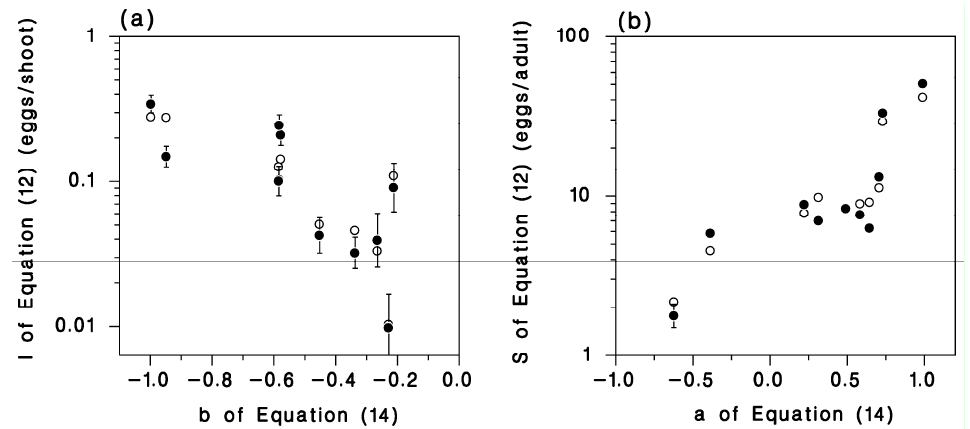
Figure 5. Relationships between parameters of Equations (13) and (14). ( a ) I , intercept of Equation (13) (immigration rate in eggs/shoot) is explained mostly by b , slope of Equation (14), the rest by M , the regional-mean density, predicted values calculated with Equation (16). ( b ) S , slope of Equation (13) (realized fecundity in eggs/adult) is explained mostly by a , intercept of Equation (14), the rest by b , its slope, predicted values calculated with Equation (15). Vertical bars are SE of the parameter. On average over our 10 single-year datasets, a = 0.369, b = − 0.158 and M = 0.027 adults/shoot. These correspond to I = 0.126 eggs/shoot and S = 14.25 eggs/adult. Two of these datasets have slopes b very near − 1 (Figure 4a,h) suggesting extensive emigration rates near the extreme case of panmixis when all moths redistribute among all populations ( α = 1). Three others are close to the opposite case with the apparent absence of emigration ( α = 0), with slope b near 0 (Figure 4d,e,g). The rest (Figure 4b,c,d,f) are in the intermediate range where b ≈ − 0.5. In general, one can expect apparent fecundity to be high in regions undergoing an outbreak (high M ) in years when the emigration rate is high ( α → 1). Under such circumstances, the apparent fecundity in sink populations, where local densities are lower than average, become much higher than expected fecundity. Conversely, apparent fecundity in sources, where densities are above the regional mean, are lower than expected fecundity. The result is homogenization of populations in a highly density-dependent manner with lower-density populations in any one year experiencing greater per capita recruitment rates as a result of net immigration of gravid moths. These moths are leaving high-density populations which then have low per capita egg recruitment rates. 3.3. Western Spruce Budworm The best fit in this long-term, multi-location dataset was obtained with Equation (3) (density-independent fecundity and emigration a random process) using parameter values α = 0.59, β = 0.27, and constant fecundity F = 218 eggs/female. The resulting R 2 between observed and expected apparent fecundity (on regular scale) is 0.32. Using Equation (11) (density-dependent fecundity and emigration rate) the best fit was obtained with α = 1, β = 0.26 (on regular scale, R 2 = 0.40), a significant improvement in goodness of fit (Mallows C P = 1.0 with Equation (11) compared to C P = 18.2 with Equation (3)).